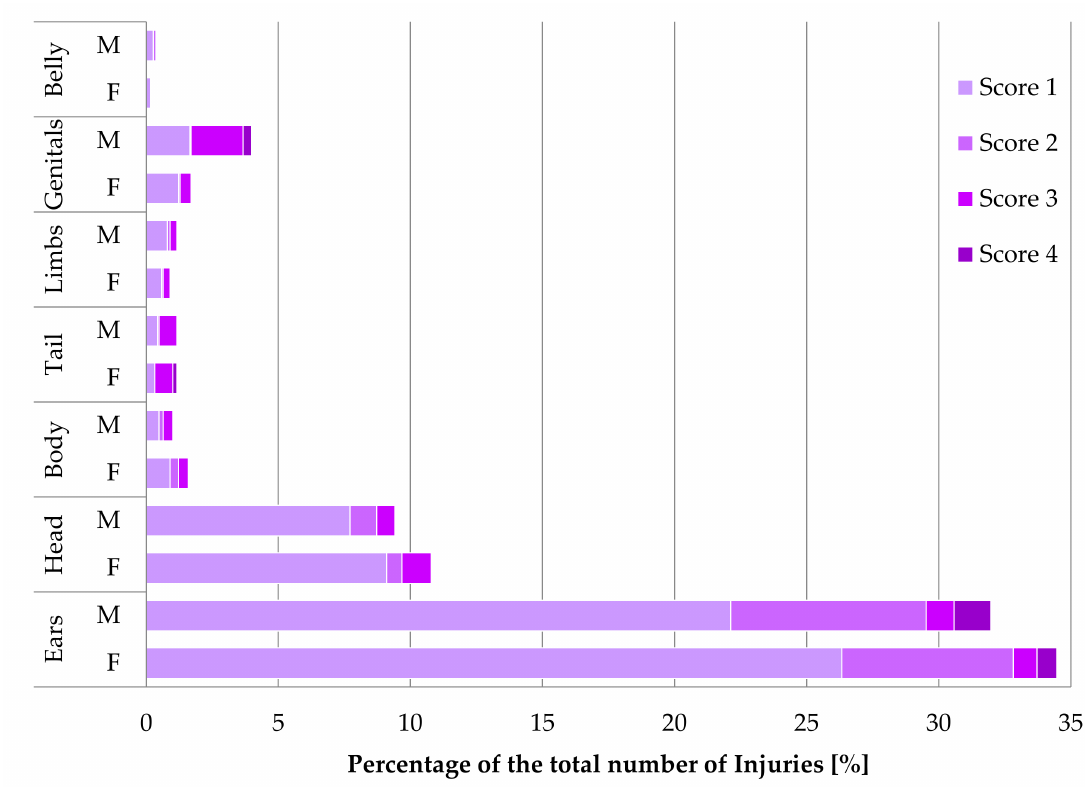
Figure 3. Distribution of the total number of skin lesions (% N = 1880) at di ff erent body parts considering the given scores 1–4 (Table 1) in female (F) and male (M) rabbits from both housing